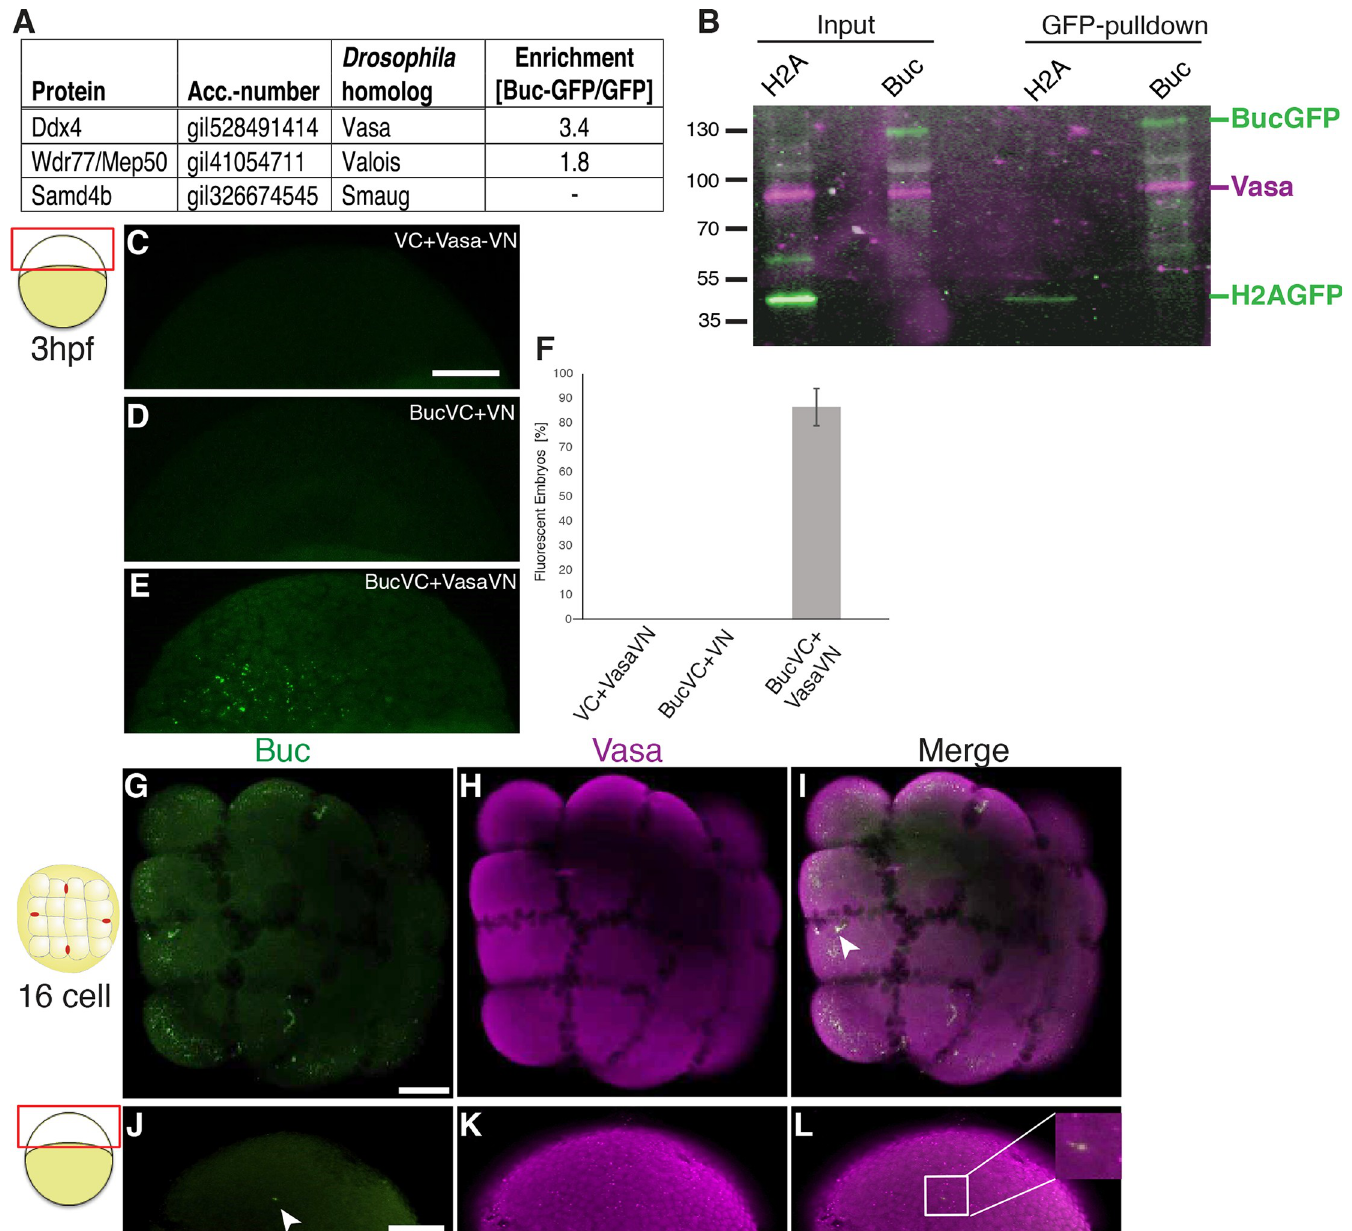
Fig 6. Buc binds zebrafish Vasa. (A) Zebrafish homologs of known Oskar binding proteins in the Buc-interactome detected Vasa (Ddx4) and Valois (Wdr77/Mep50), but not Smaug (Samd4b). Enrichment indicates the ratio of unique peptide counts after Buc-GFP pulldown to GFP-control samples. (B) Buc binds to Vasa in vivo during germ cell specification. Immunoprecipitations from 3 hpf H2A-GFP (42 kD) or Buc-GFP (130 kD) transgenic embryos blotted with GFP (green) and Vasa (magenta) (input = 20% of pulldown). (C-F) Buc and Vasa interact in bimolecular fluorescent complementation assays (BiFC). (C-E) live embryos at 3 hpf as indicated by the cartoon on the left, are not fluorescent (green) upon injection of mRNA encoding VC with Vasa-VN (C; 0 ± 0%; n = 67) or Buc-VC with VN (D; 0 ± 0%; n = 56), but form fluorescent Venus protein with Buc-VC and Vasa-VN (E; 86.5 ± 7.5%; n = 53). Scale bar (C-E): 100 μ m. (F) Quantification of BiFC assay (three independent experiments for each RNA). Error bars represent standard deviation of the mean. (G-L) Immunostaining of 16-cell stage (G-I) or 3 hpf (J-L) embryo as indicated by the cartoon on the left showing expression of Buc (green) and Vasa (magenta), inset in (L) shows a 10x magnification of the boxed area. Scale bar (G-L): 200 μ